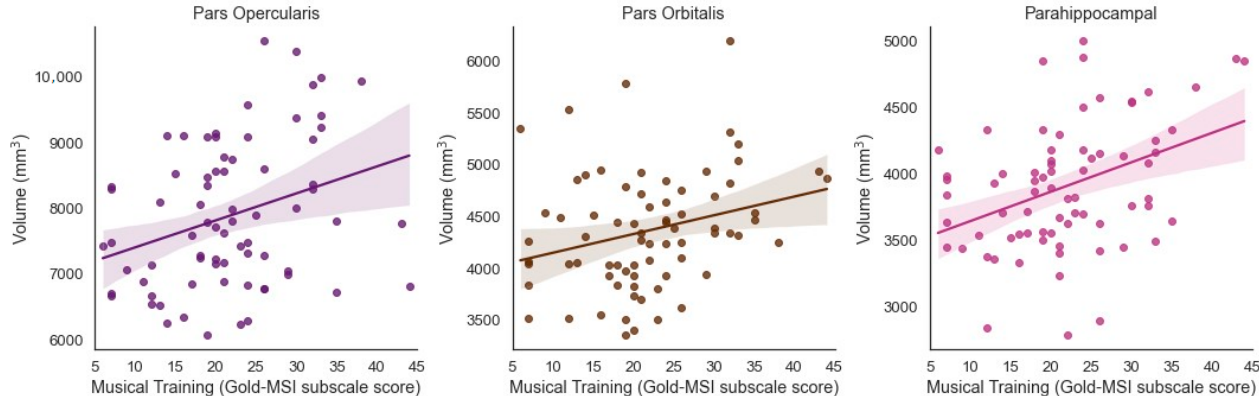
Figure 2. Significant positive associations between Musical Training (Gold-MSI) and volume of the bilateral inferior frontal cortex (pars opercularis and pars orbitalis) and parahippocampus in older adults (Benjamini-Hochberg corrected).